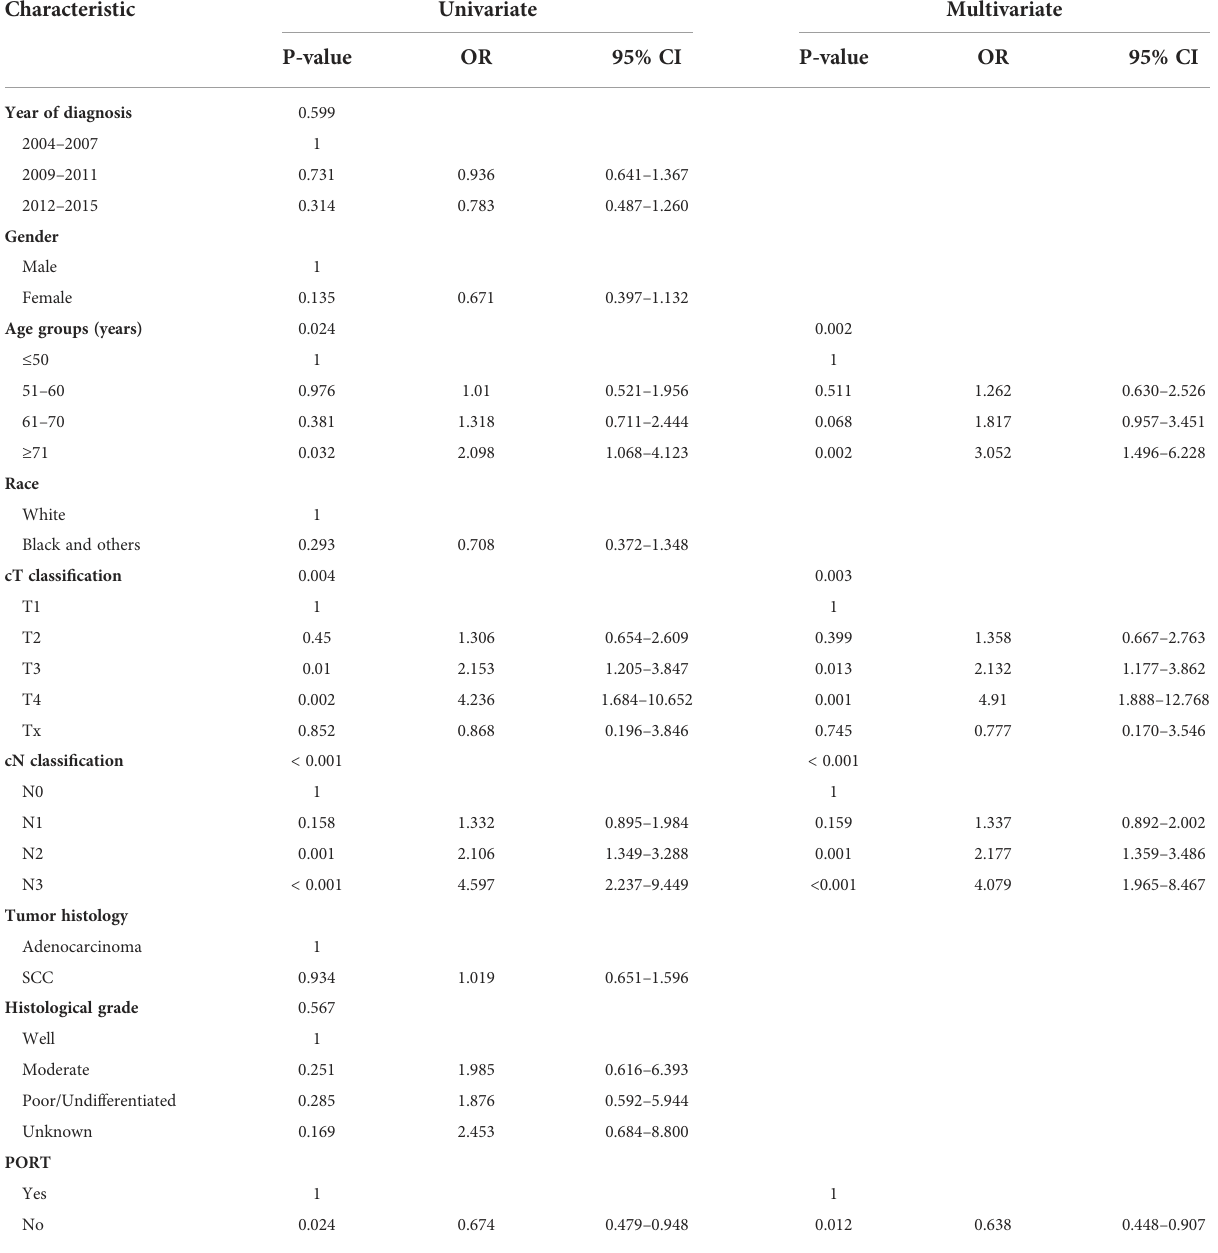
TABLE 2 Univariate and multivariate analysis of OS for the matched cohort after